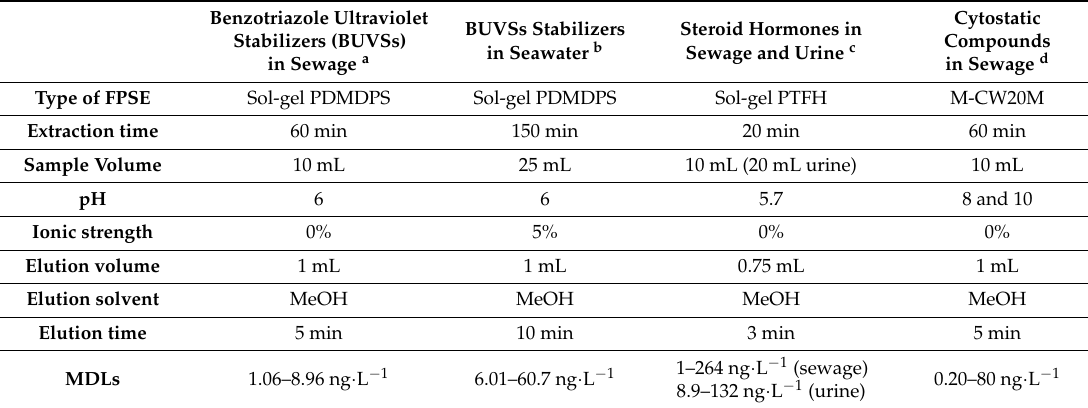
Table 1. Optimum FPSE conditions and method detection limits (MDLs) for the determination of ultraviolet (UV) stabilizers, hormones and cytostatic